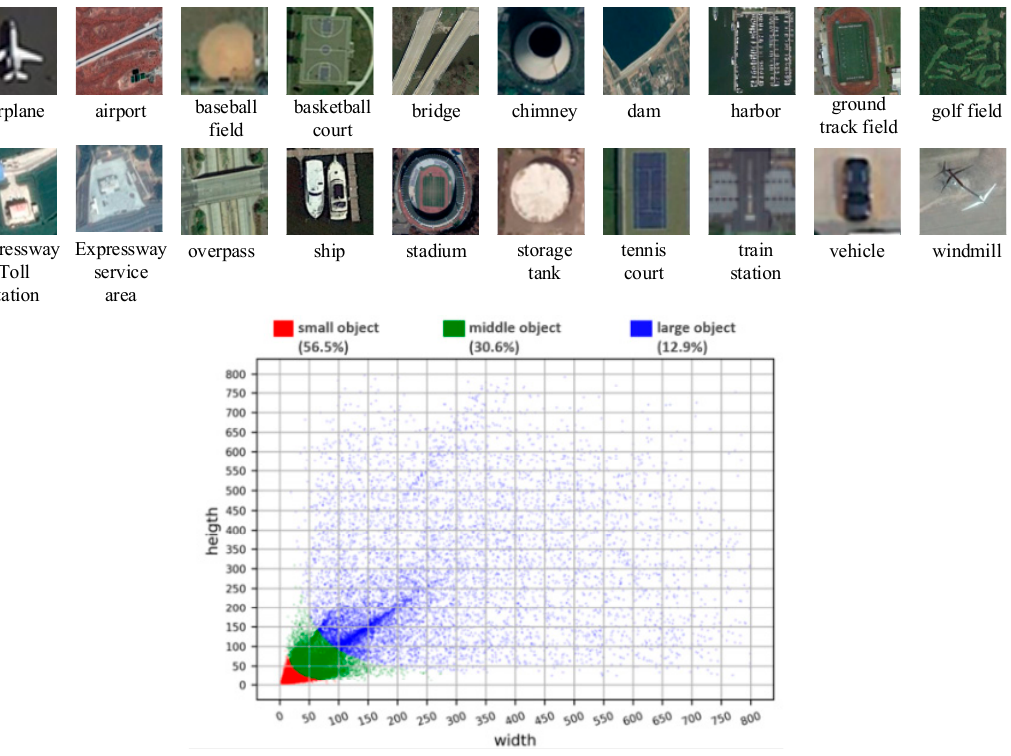
Figure 10. Each category and the size distributions of objects in DIOR.